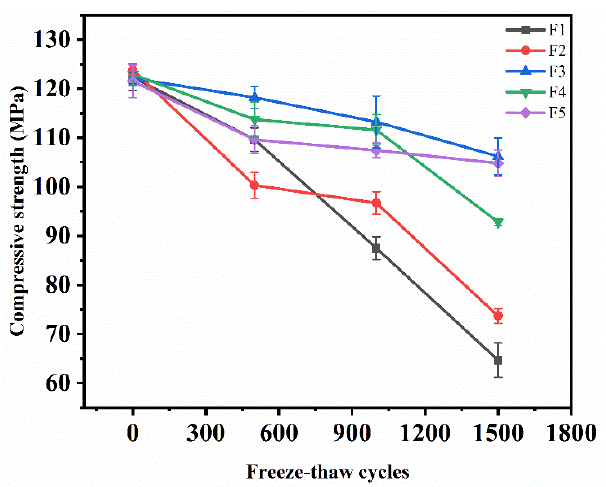
Figure 5. Variation in the compressive strength during salt freezing cycles. (F1: Composite salt and